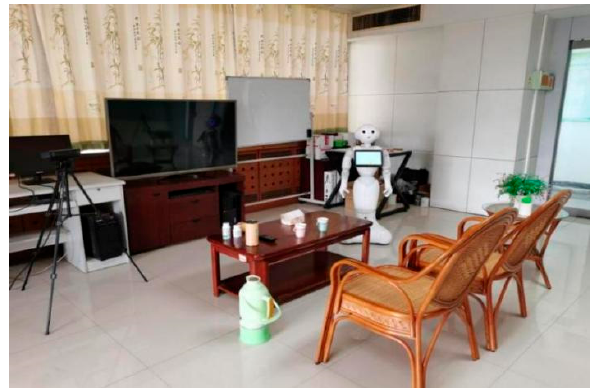
Figure 6. Schematic diagram of the experiment scene.